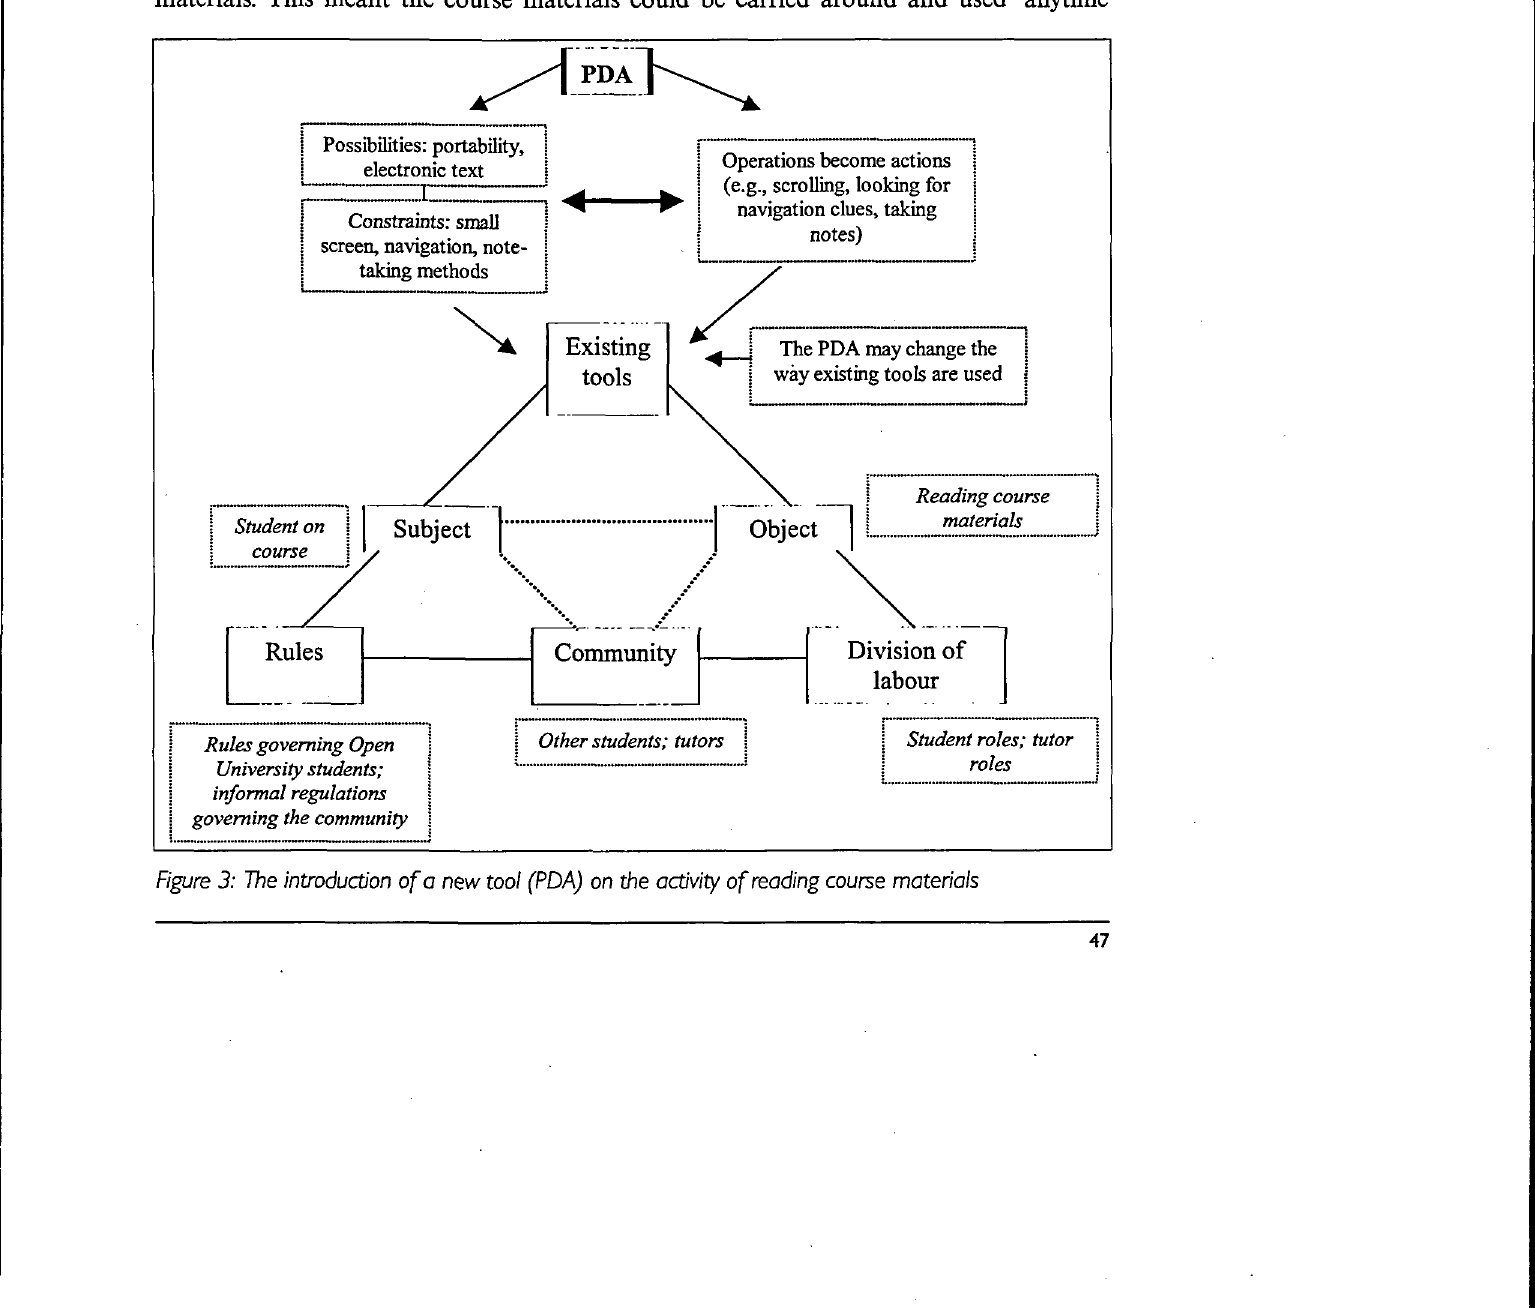
Figure 3: The introduction of a new tool (PDA) on the activity of reading course